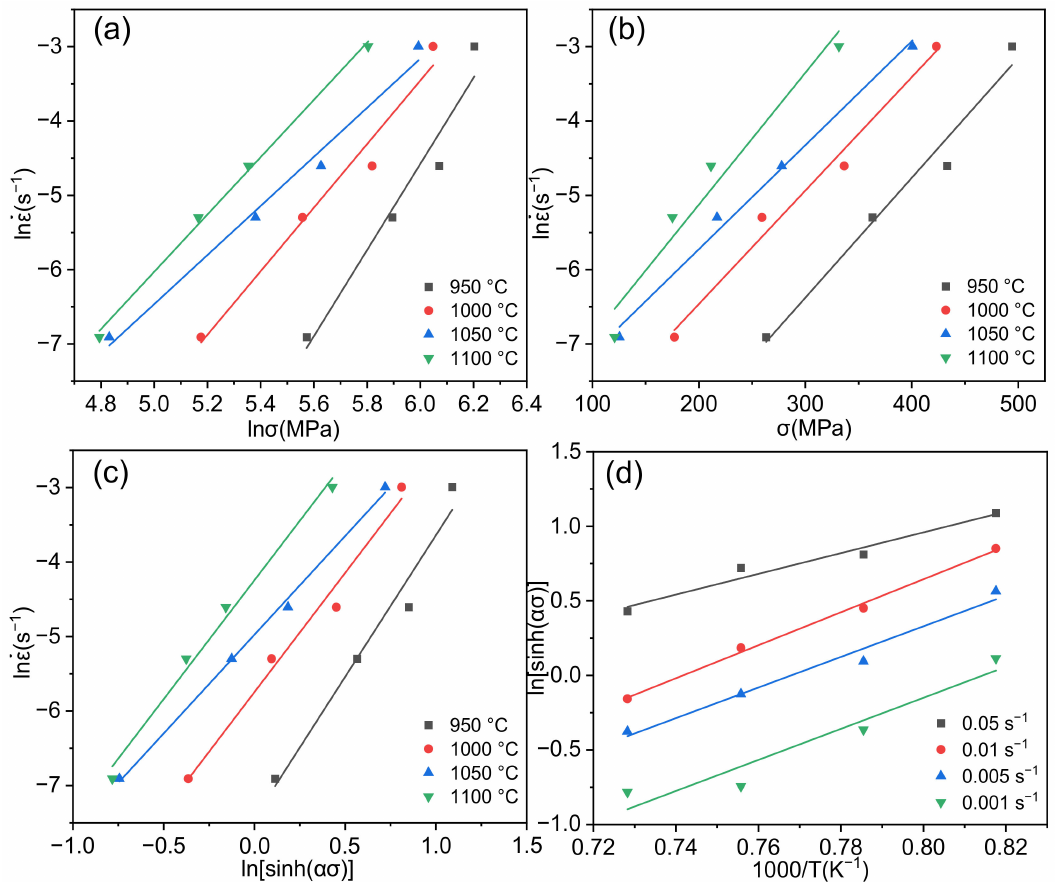
. . . ε and ln σ , ( b ) ln ε and σ , ( c ) ln ε and ln [ sinh ( ασ )] ,